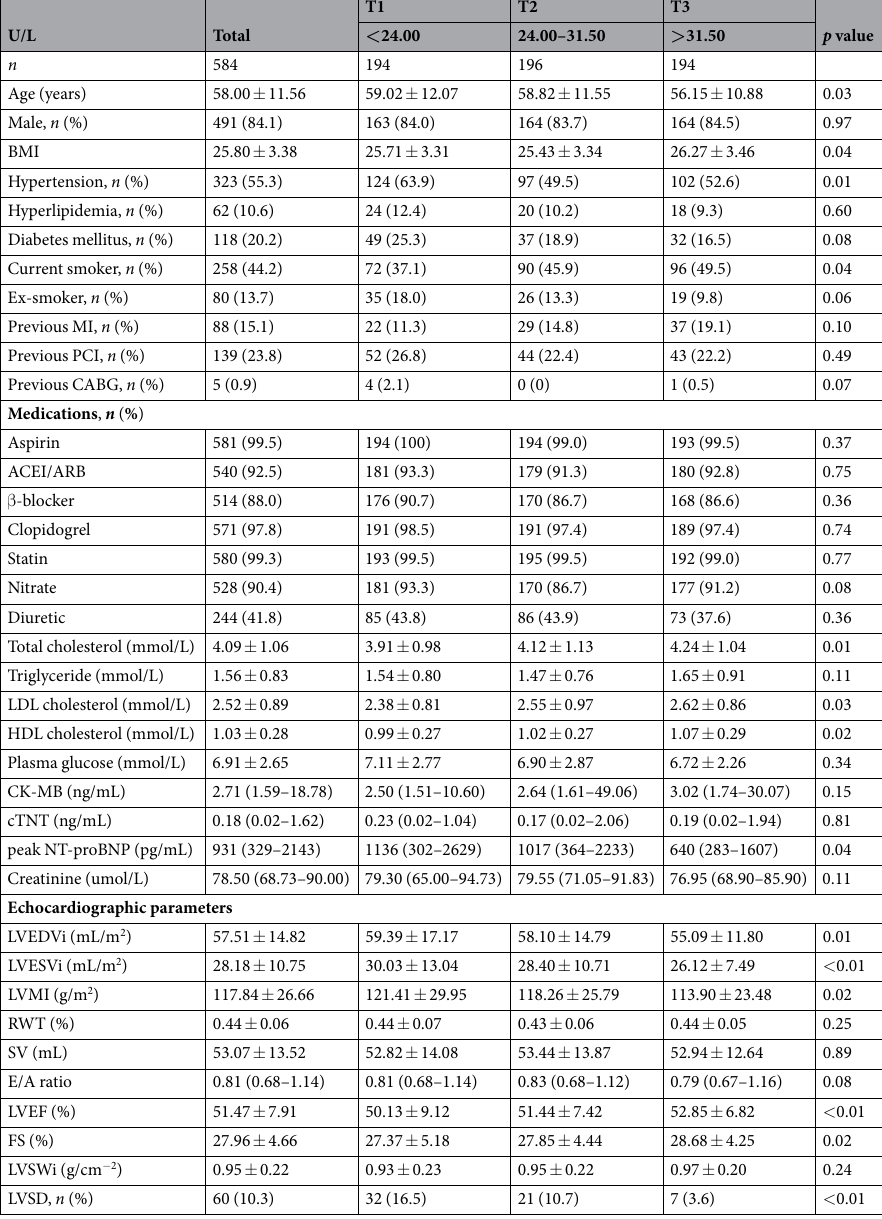
Table 1. Demographic, clinical and echocardiographic parameters in STEMI patients according to tertiles of DPP4a. A, maximum late transmitral velocity in diastole; ACEI, angiotensin-converting enzyme inhibitor; ARB, adrenergic receptor binder; BMI, body mass index; BNP, brain natriuretic peptide; CABG, coronary artery bypass grafting; CK-MB, MB isoenzyme of creatine kinase; cTNT, cardiac troponin T; E, maximum early transmitral velocity in diastole; FS, subendocardial fractional shortening; HDL, high-density lipoprotein; LDL, low-density lipoprotein; LV, left ventricular; LVEDVi, LV end-diastolic volume index; LVEF, LV ejection fraction; LVESVi, LV end-systolic volume index; LVMI, LV mass index; LVSD, LV systolic dysfunction; LVSWi, LV stroke work index; MI, myocardial infarction; PCI, percutaneous coronary intervention; RWT, relative wall thickness; SV, stroke volume. Data are expressed as mean ± SD or median (interquartile range), and categorical variables as numbers and